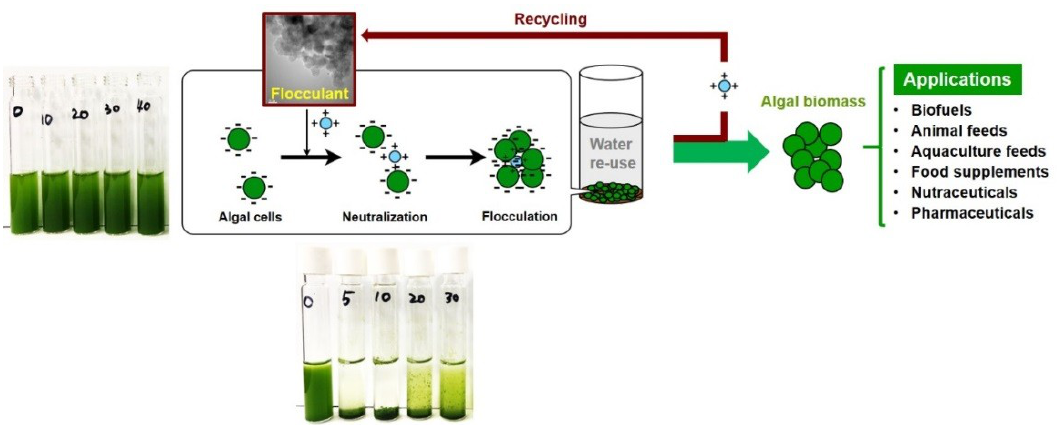
Figure 1. Schematic diagram of the flocculation harvesting process of algal cells with a recyclable flocculant.